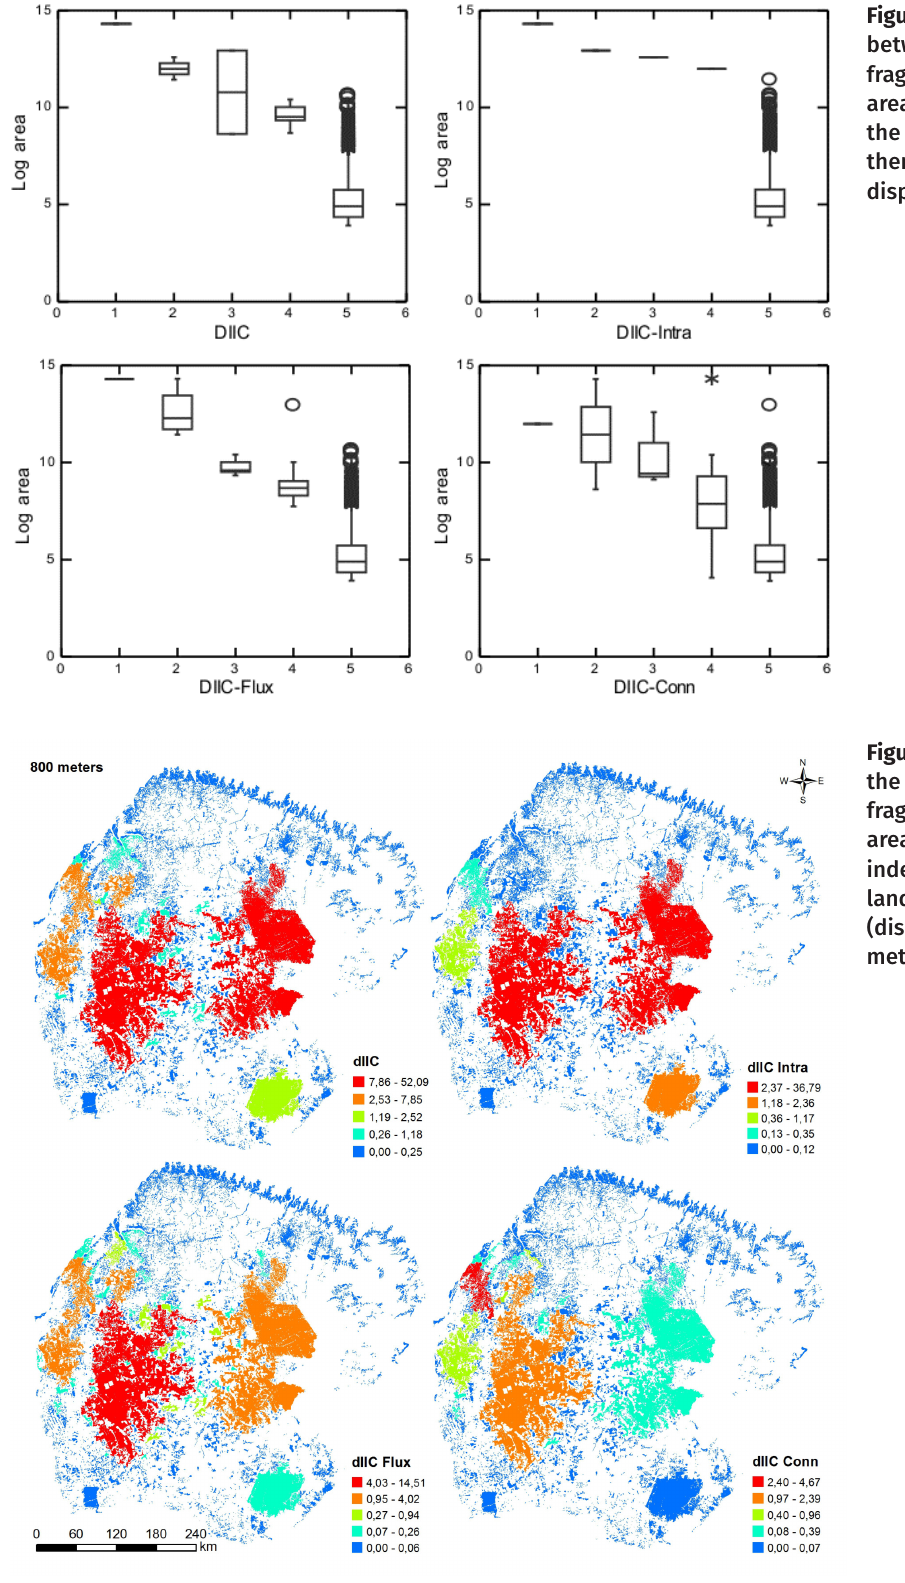
Figure 2. Relationship between the size of the fragments in the Belém area of endemism and the importance given to them by each index (800m dispersal).